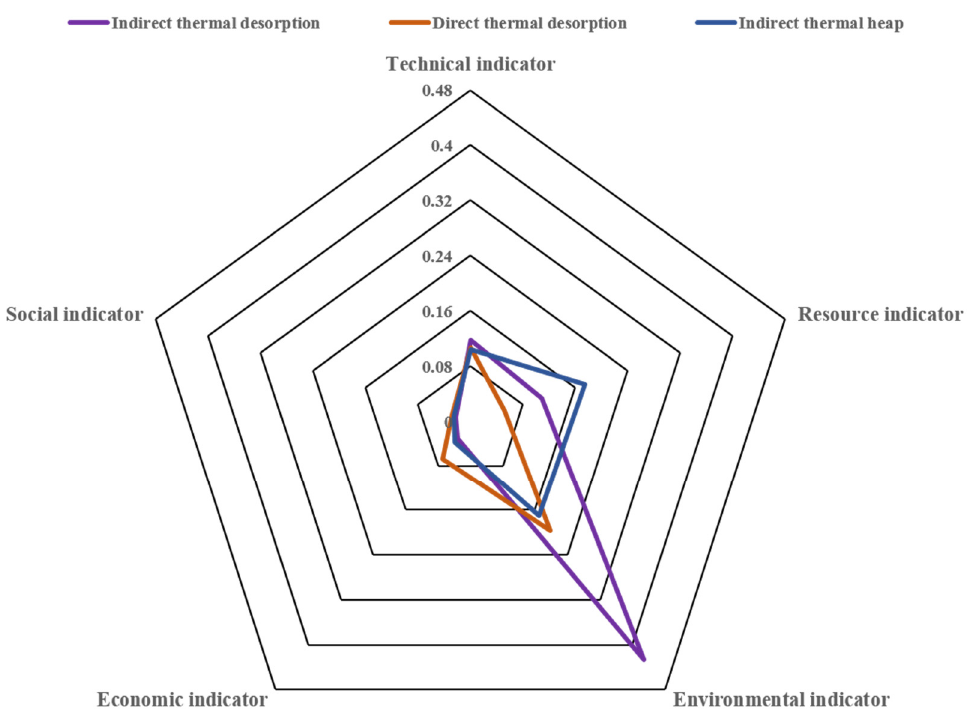
Figure 6. Comprehensive comparison radar map for the three ex situ thermal desorption technol- ogy.